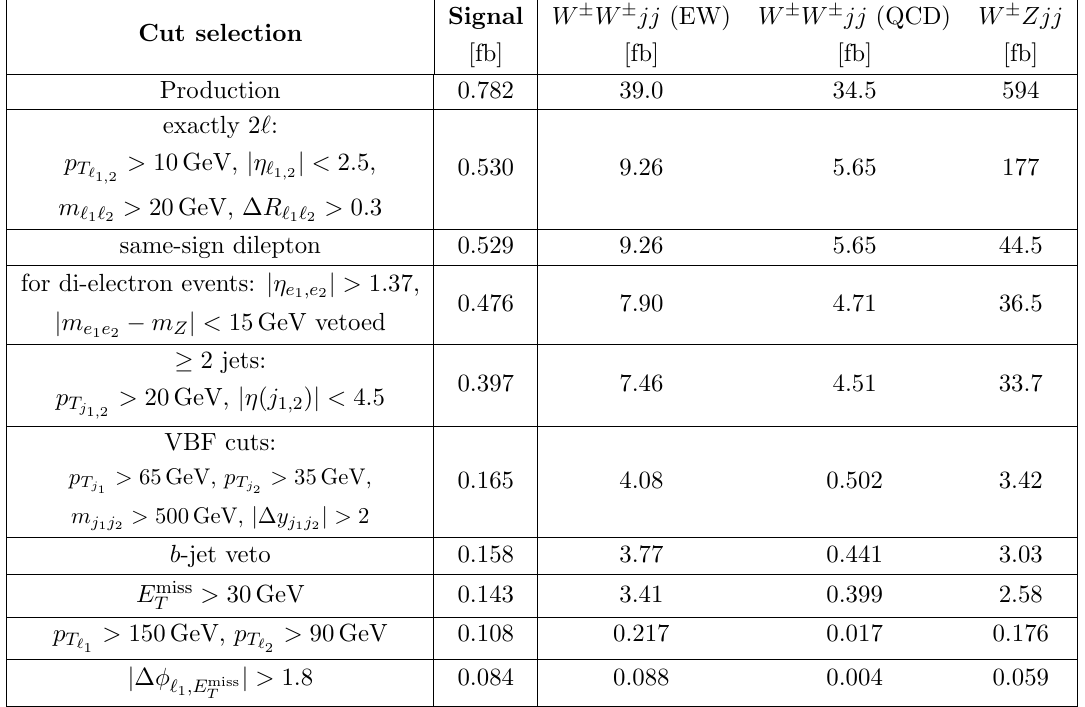
Table 2 . Cut-(cid:13)ow table of the signal, with m (cid:30) = 1 GeV, and SM backgrounds W (cid:6) W (cid:6) jj (EW),